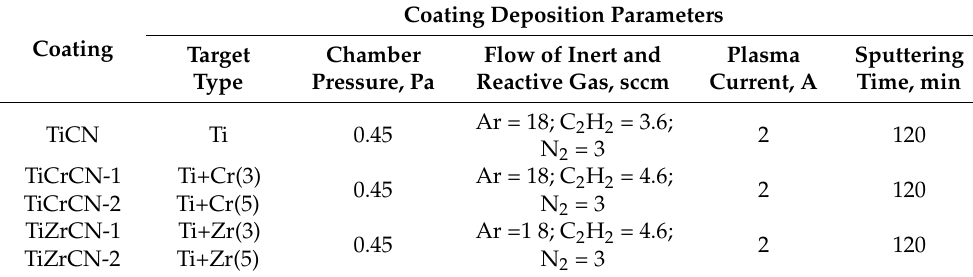
Figure 2. Scheme of the process of preparing the substrate and coating deposition. Table 2. Magnetron sputtering parameters for the deposited coatings.